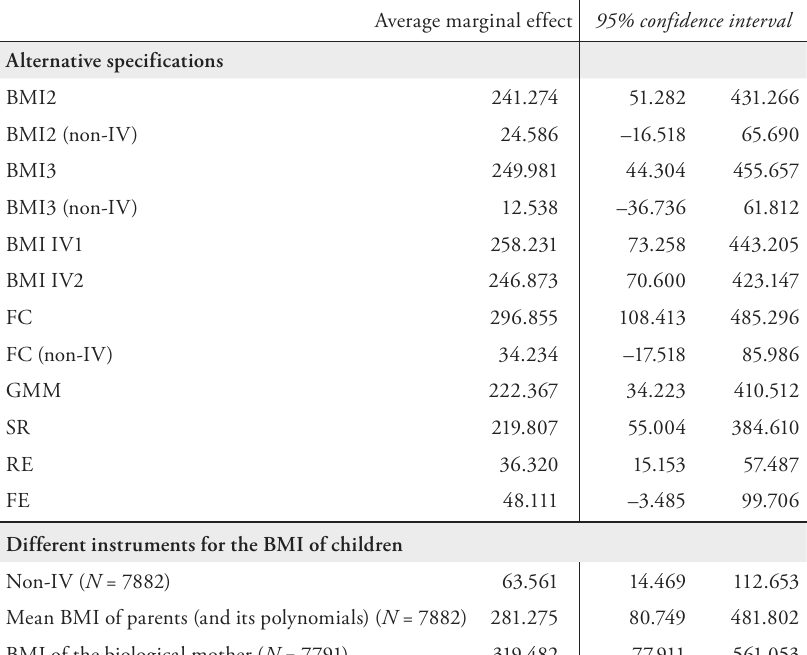
Table 11: Estimated Marginal Effects from the Robustness